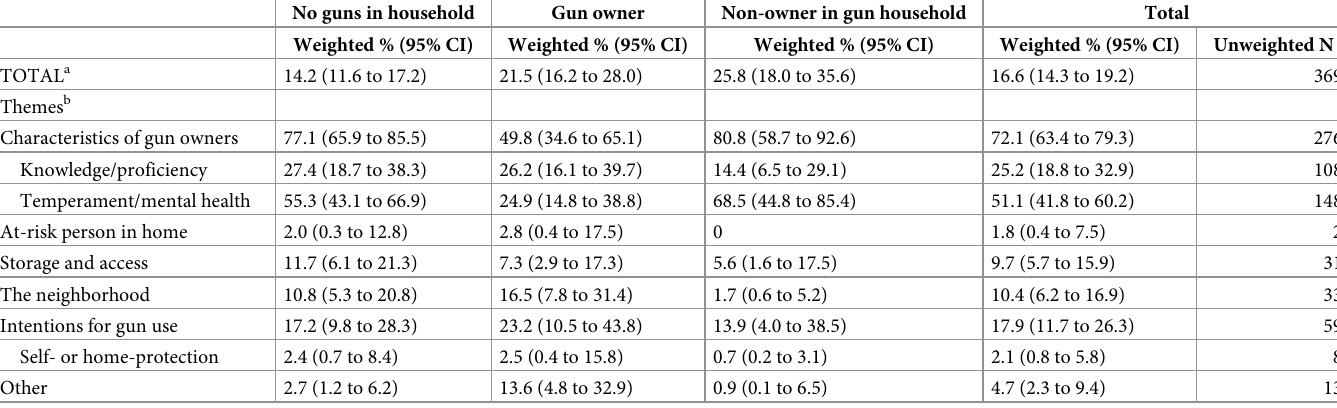
Table 5. Percentage of respondents who reported “it depends” whether guns make homes safer or more dangerous and factors on which it depends, by firearm own- ership status. The neighborhood scenario. No guns in